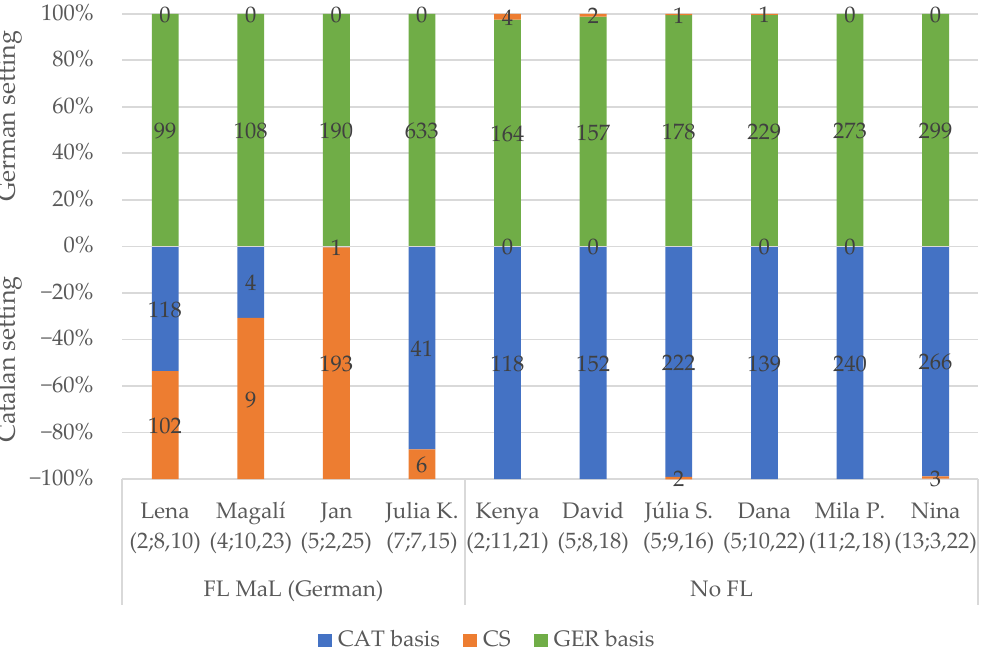
Figure 20. Children following FLP 1 with FL German or no FL: Catalan and German setting.